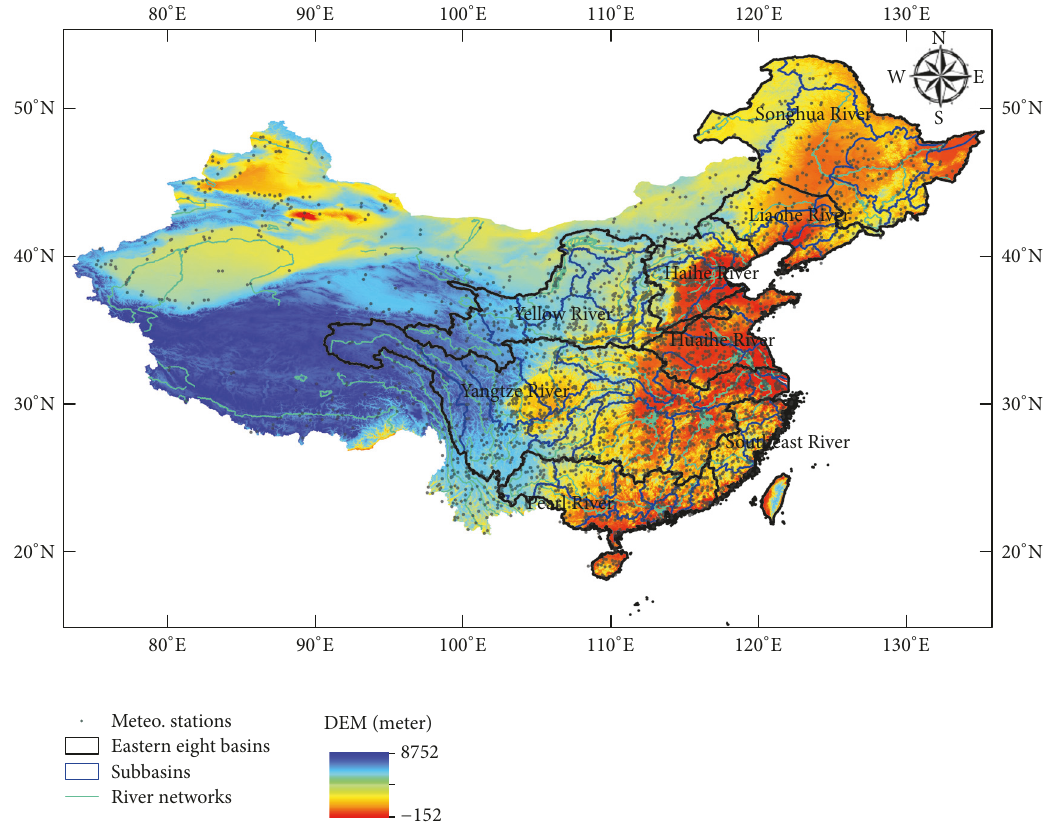
Figure 1: Study area and location of about 2400 gauges used in CPAP.